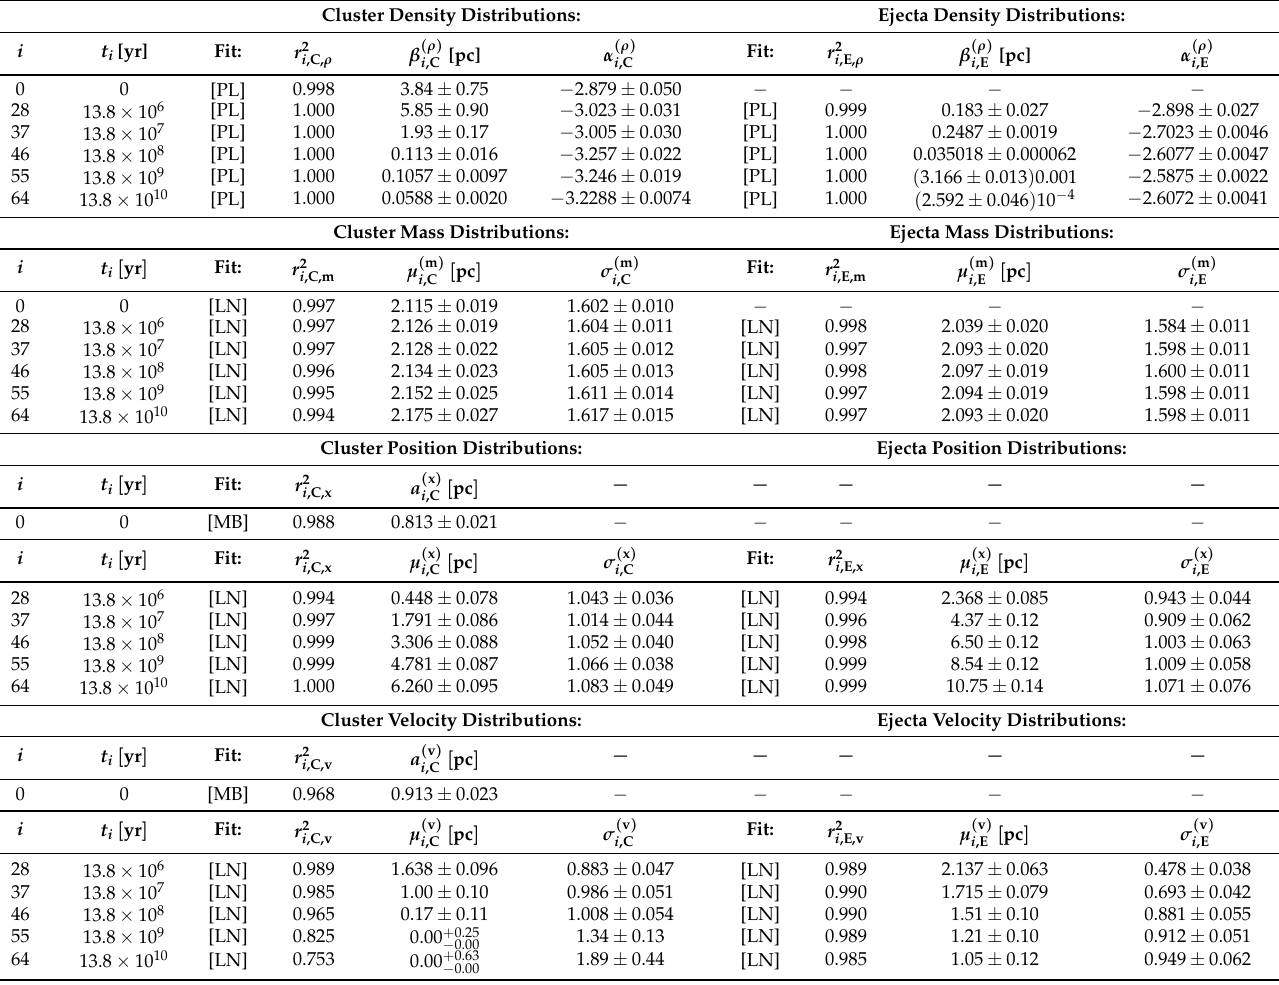
Table 14. Density, mass, position and velocity quasi-static profile fits segregated by population (cluster and ejecta) type of Figure 12. The density profile has been fitted to a PL [PL] in the range delimited by the 0th and 80th percentiles in position so as to ensure that the density is computed within the cluster and ejecta spheres. The fit is, following Equation (31), ρ z ( t i ) = β i ,P t α i ,P , where α i ,P is the PL index, and corresponds roughly to the constant value of the differ- i ential counts, while β i ,P in turn, corresponds to the amplitude of the PL. The mass, position and velocity profiles has been fitted to either a Log-Normal or a Maxwell–Boltzmann (MB) distribution. In the case of the Log-Normal fit, then the standard deviation, both for the z variable’s natural logarithm. In the case of a Maxwell–Boltzmann fit,